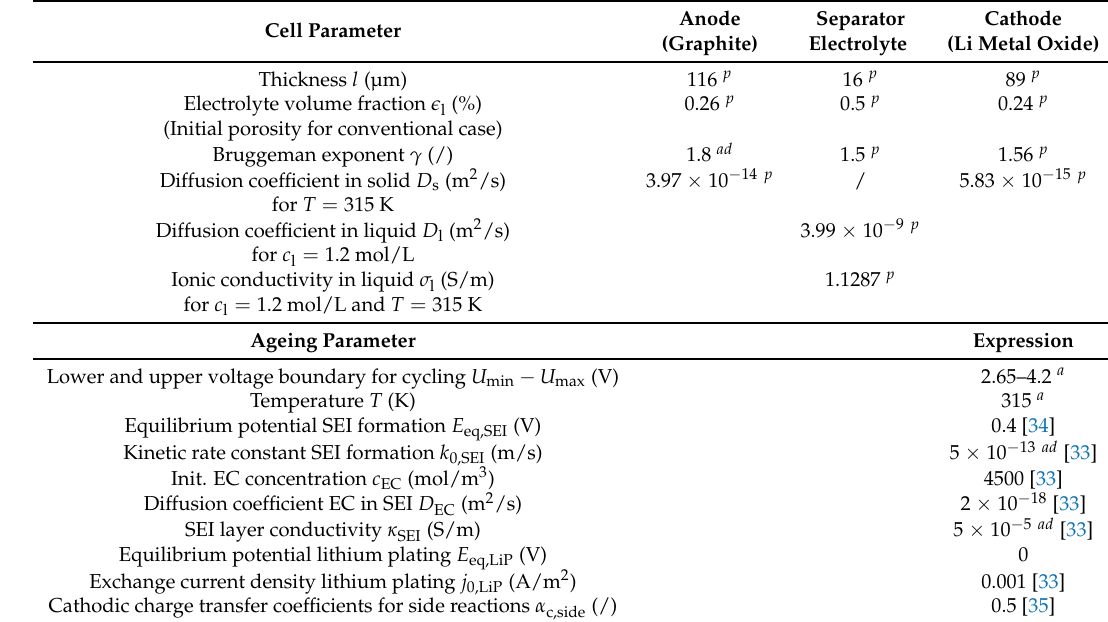
Table A1. Selected cell and ageing parameters used in this work. Superscripts used are p for the provided parameter set, a for assumed and ad for adjusted